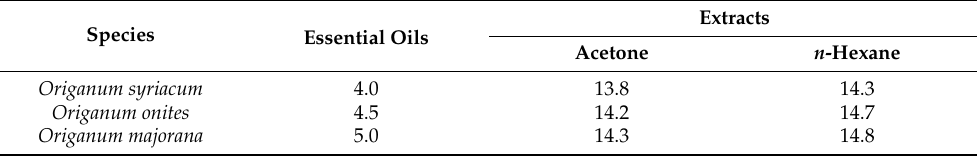
Table 1. The yields of essential oils and extracts (g/100 dried plant materials).